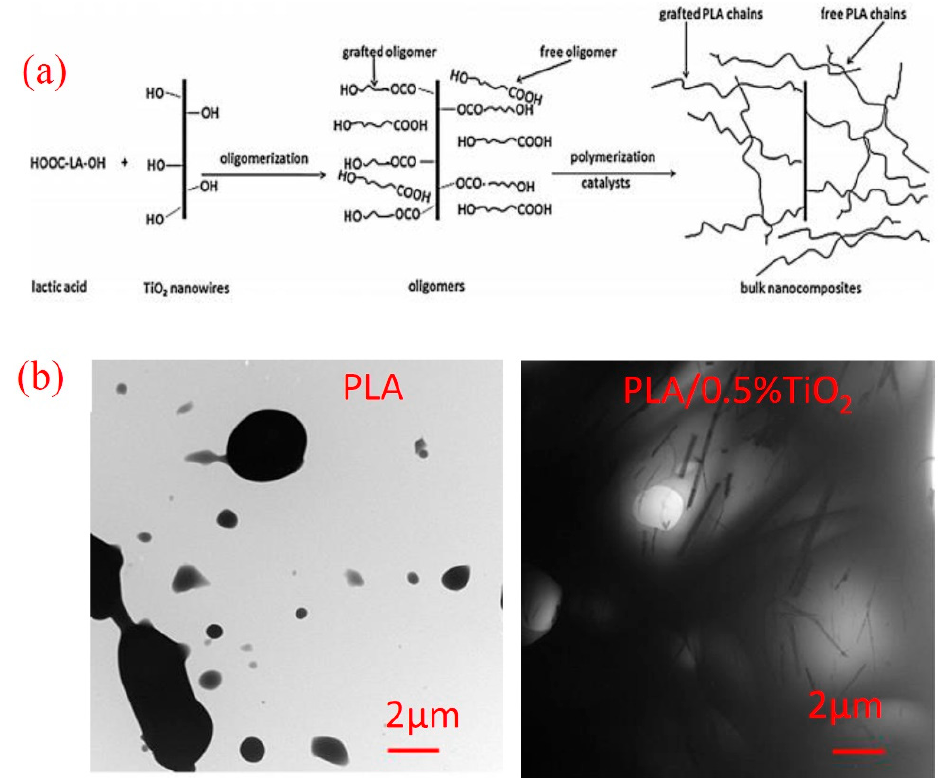
Figure 2. Scanning electron microscopy (SEM) images of TiO 2 nanoparticles where ( a ) untreated TiO 2 and ( b ) lactic acid-treated TiO 2 (g-TiO 2 ) [19].